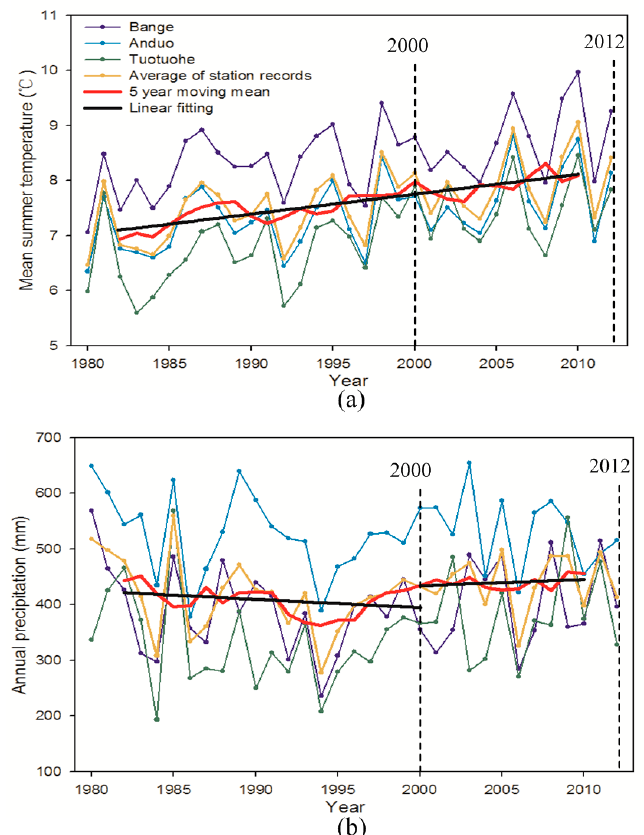
Figure 10. The records of mean summer temperature ( a ) and annual precipitation ( b ) from 1980 to 2012, which were estimated from climatic observations of the Tuotuohe, Bange, and Anduo meteorological stations. The five ‐ year moving averages of mean summer temperature and annual precipitation are shown in red lines. The changes of linear fitting in temperature and precipitation are indicated as black lines. Two vertical dashed lines indicate the year of 2000 and 2012, which are the start and end time of the period of investigation in this study.